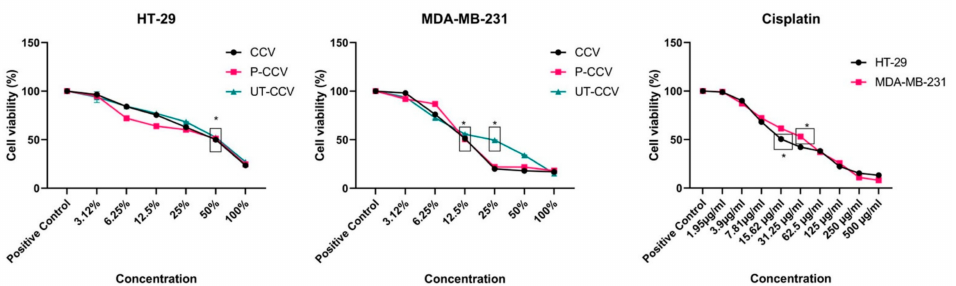
Figure 3. Cytotoxic effects of gilaburu vinegar prepared by traditional, pasteurized, and ultrasonic methods on A549, MDA-MB-231, and DU-145 cells. The vinegars were found to have dose-dependent anticancer effects on different types of cancer cells. * indicates p <